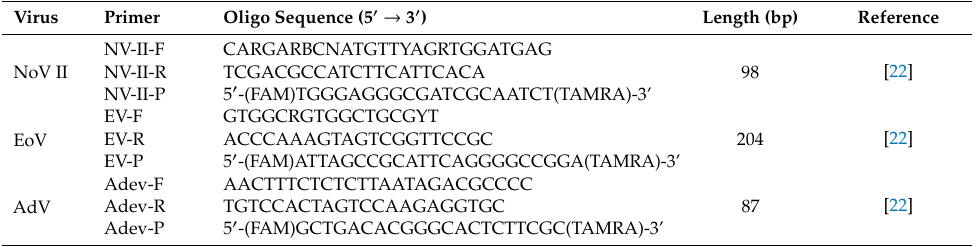
Table 2. Quantitative PCR primer set and reaction condition a